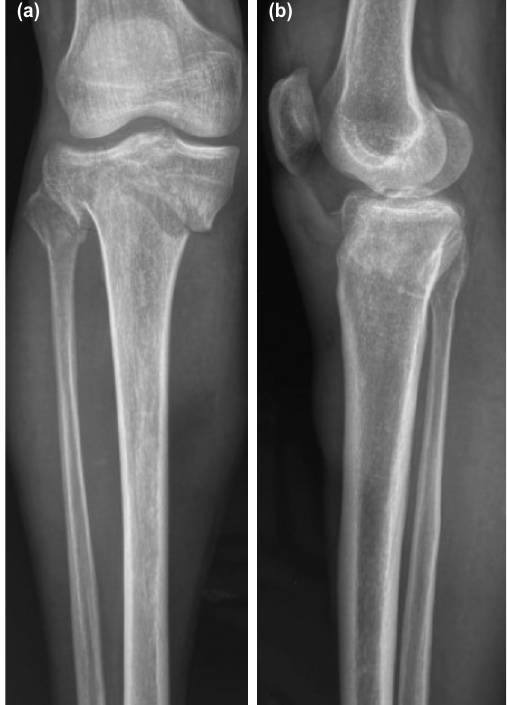
Case No.12, pre-operative radiographs of the knee Fig. 1: showing Shatzker Type VI fracture of the proximal tibia (a). Anteroposterior view. (b) Lateral view.